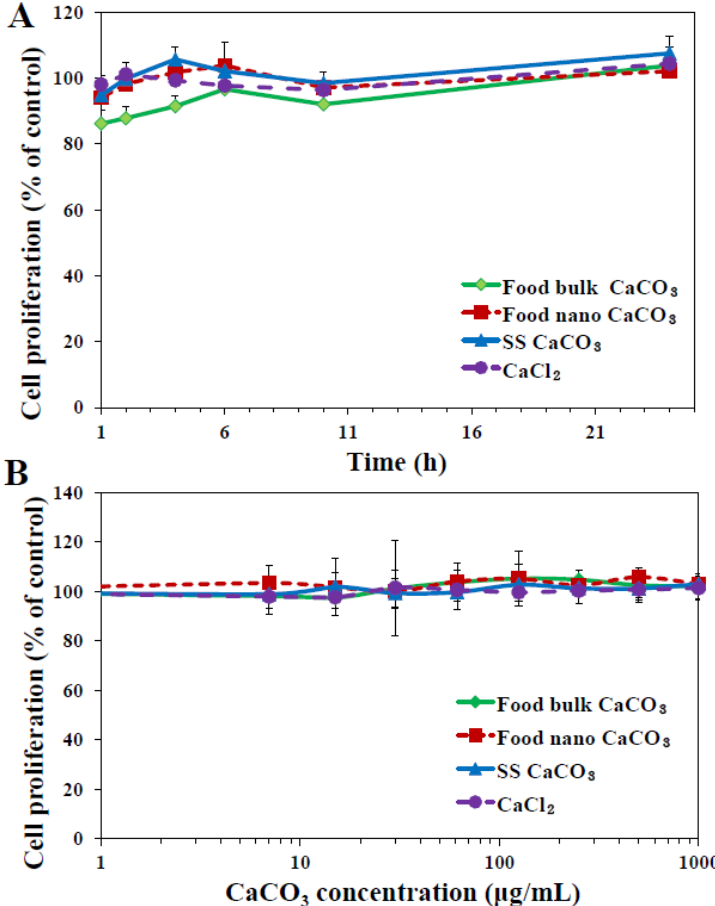
Figure 3. Effect of three different types of CaCO 3 particles on cell proliferation of human intestinal INT-407 cells, as measured by water-soluble tetrazolium salts (WST-1) assay. ( A ) Cell proliferation exposed to 250 μ g/mL particles or an equivalent amount of CaCl 2 (based on calcium content) for 1–24 h; ( B ) Cell proliferation treated with different concentrations of CaCO 3 particles or CaCl 2 for 24